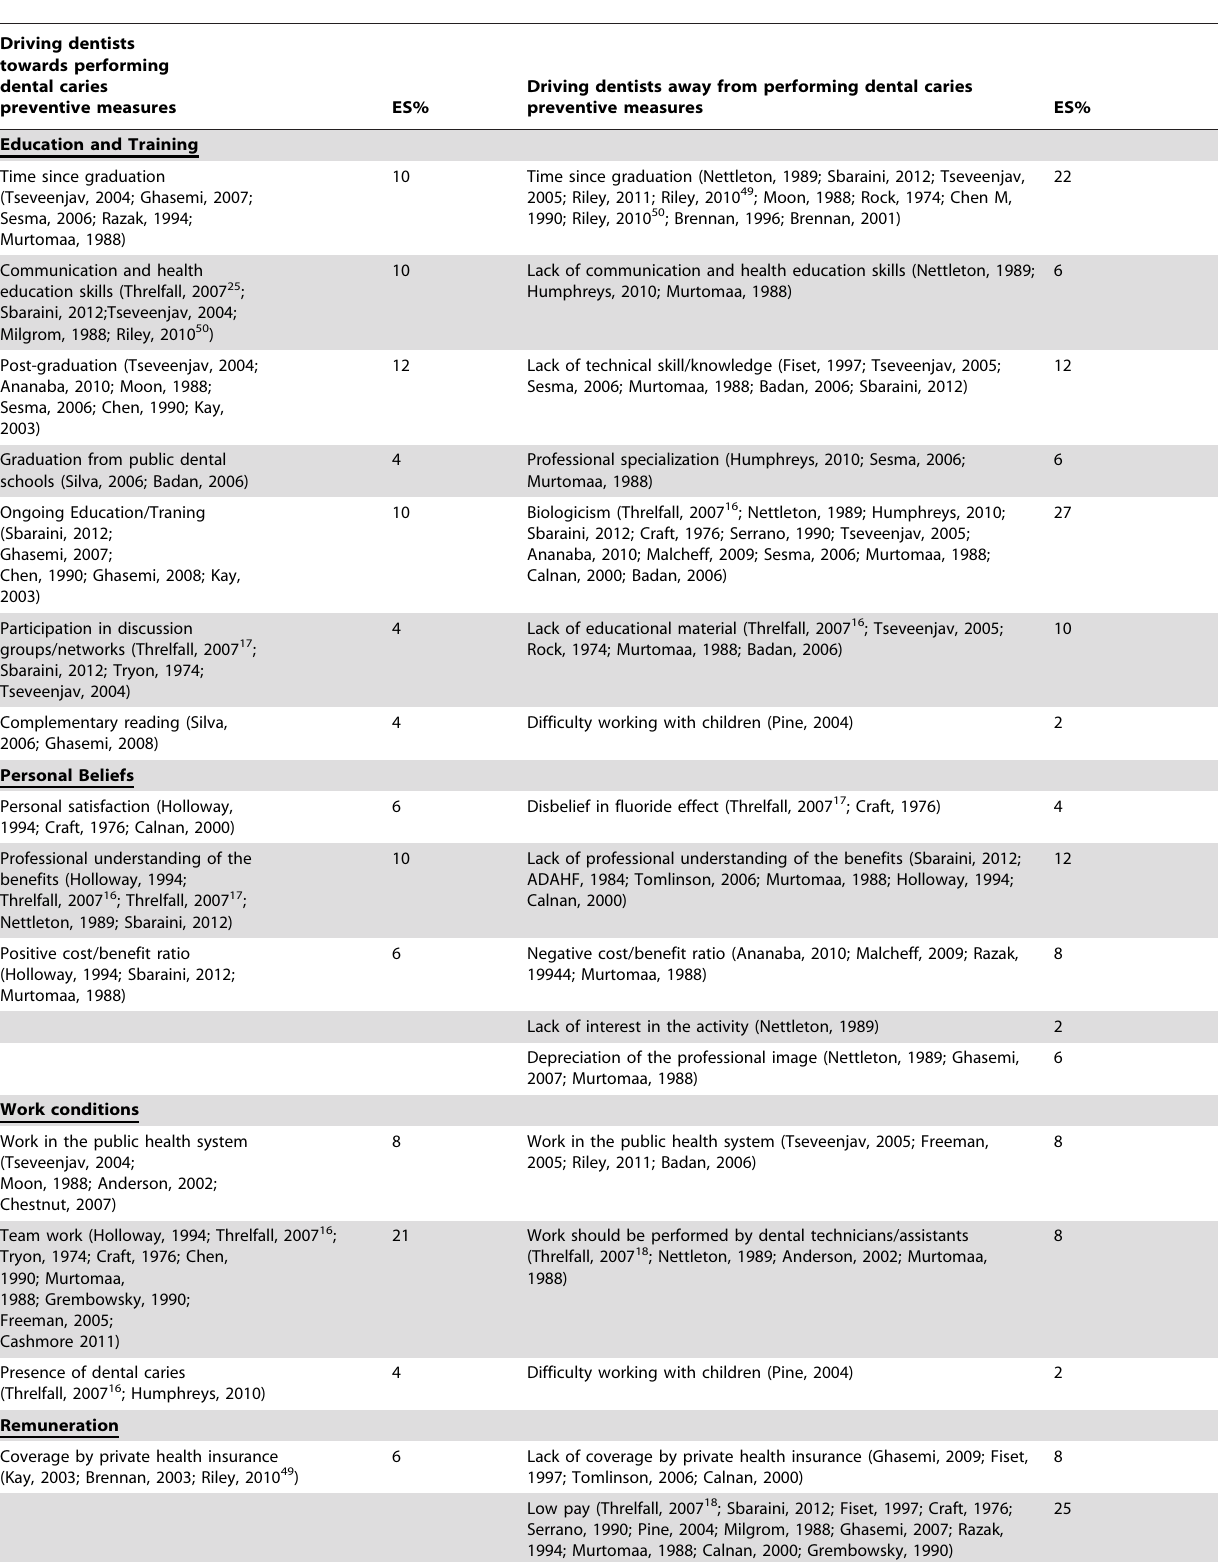
Table 3. Abstracting, formatting, grouping in categories, and frequency effect sizes (ES) of findings.